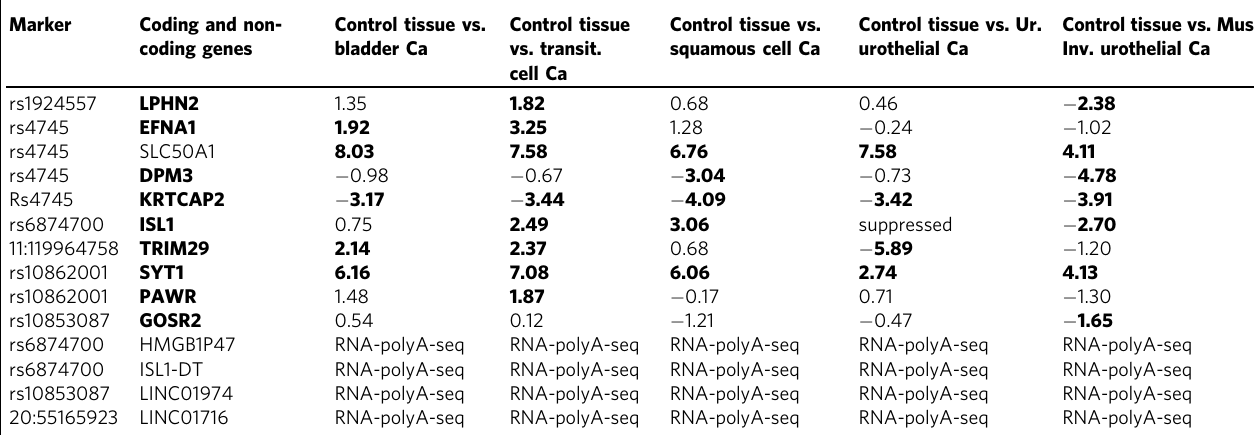
Table 5 log2-fold change of genes in the LD blocks of the most signi fi cant GWAS markers of bladder cancer cell types and muscle-invasive urothelial cancer over bladder control